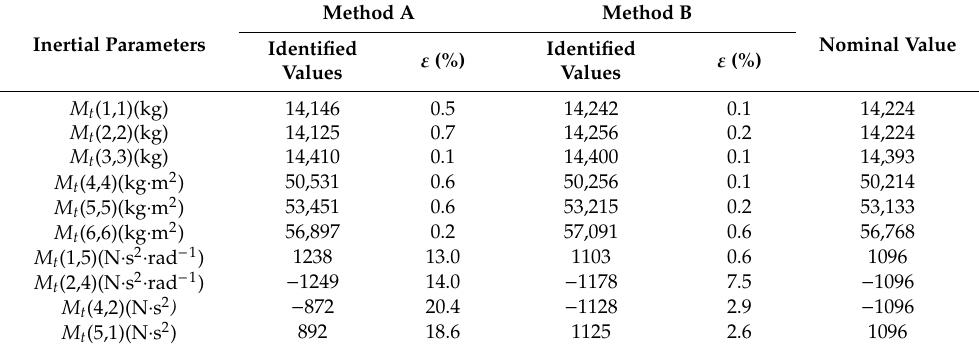
Table 4. Identification results of the inertial parameters of the Simulink ® model with 5 N Coulomb friction.